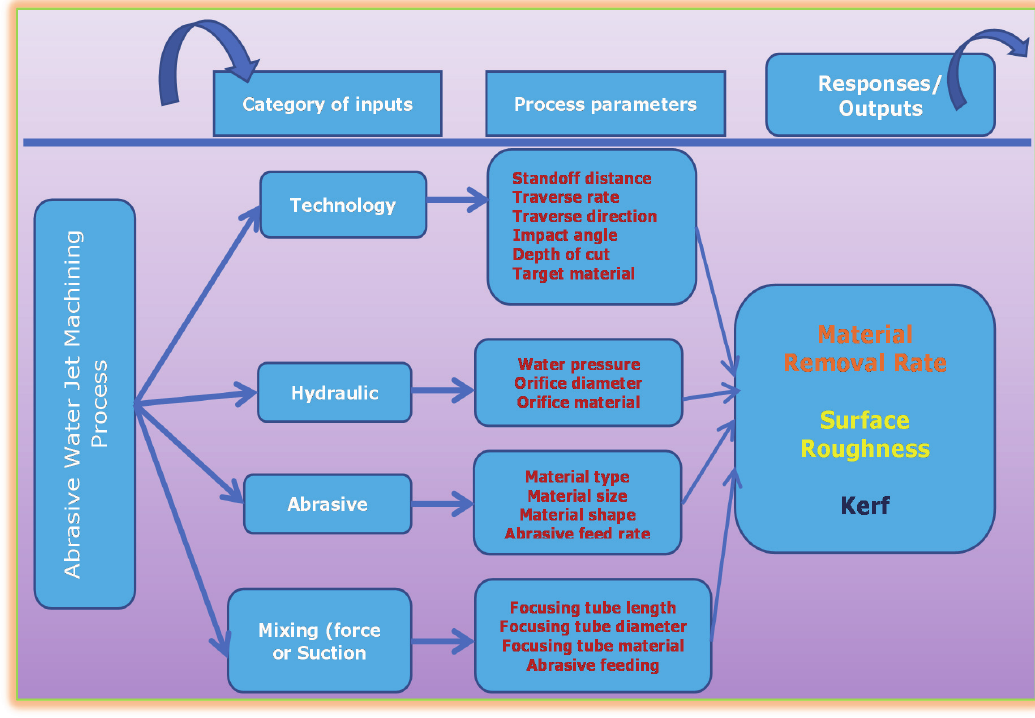
Fig. 2. Process parameters and responses in AWJ